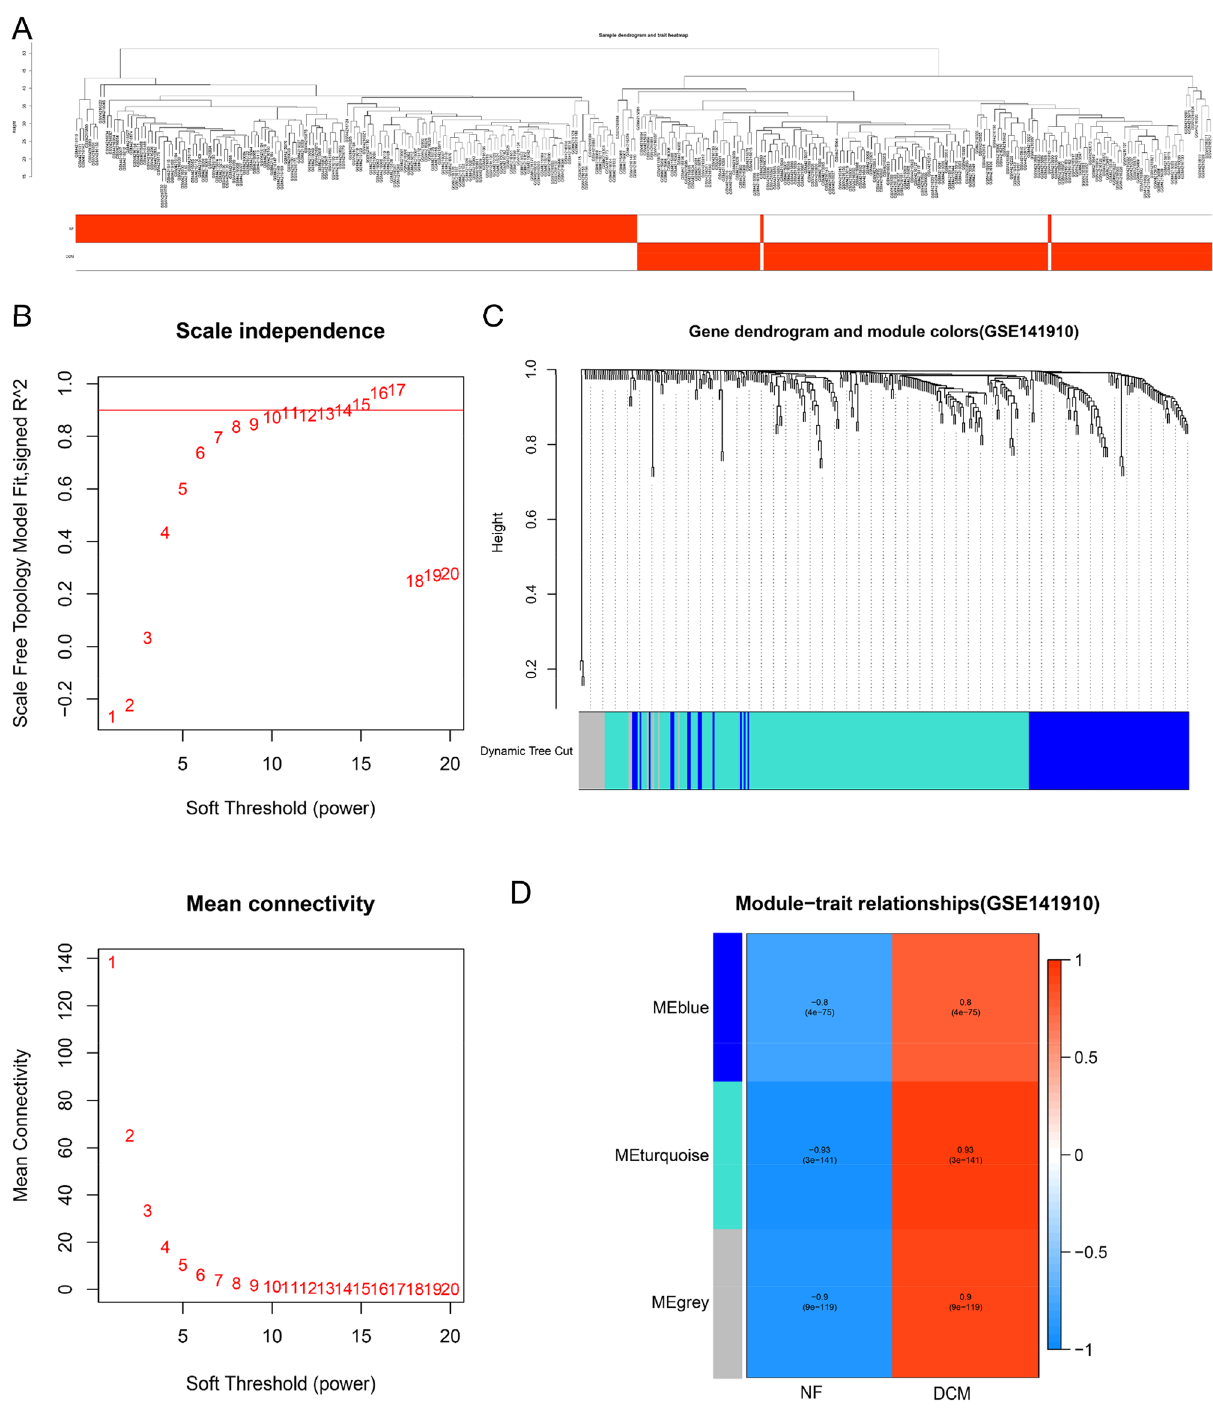
Figure 3. WGCNA identified 197 genes closely related to dilated cardiomyopathy. ( A ) The distribution of different samples. ( B ) Analyze the best Power value. ( C ) Dendrogram of all clusters expressing genes based on the difference metric (1-TOM). ( D ) The heat map shows the correlation between each module and dilated (Fig. 5C). The genes with degree > 10 were consistent with the genes of the key modules, and they were used for further analysis. What is interesting is that the degree > 10 genes are the same as 7 genes in the key modules, including CXCR1, AGTR2, ADORA3, CXCL10, CXCL11, CXCL9, SAA1. We used these genes for further analy- sis to screen for genes that best predicted DCM.